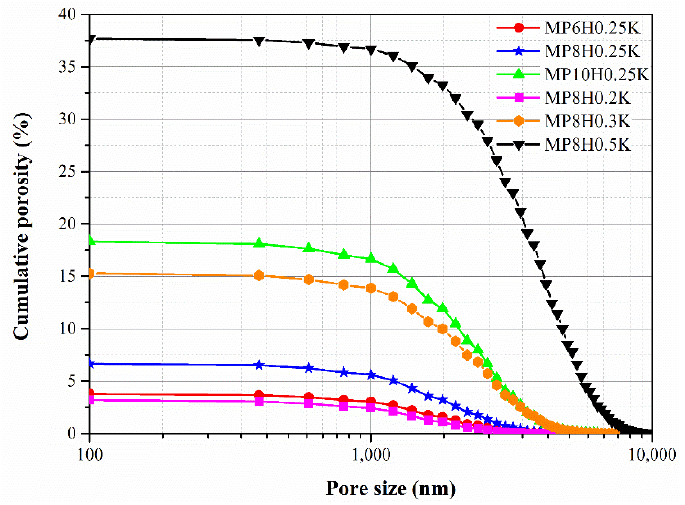
Figure 9. Comparison of cumulative porosity in different MKPC pastes.